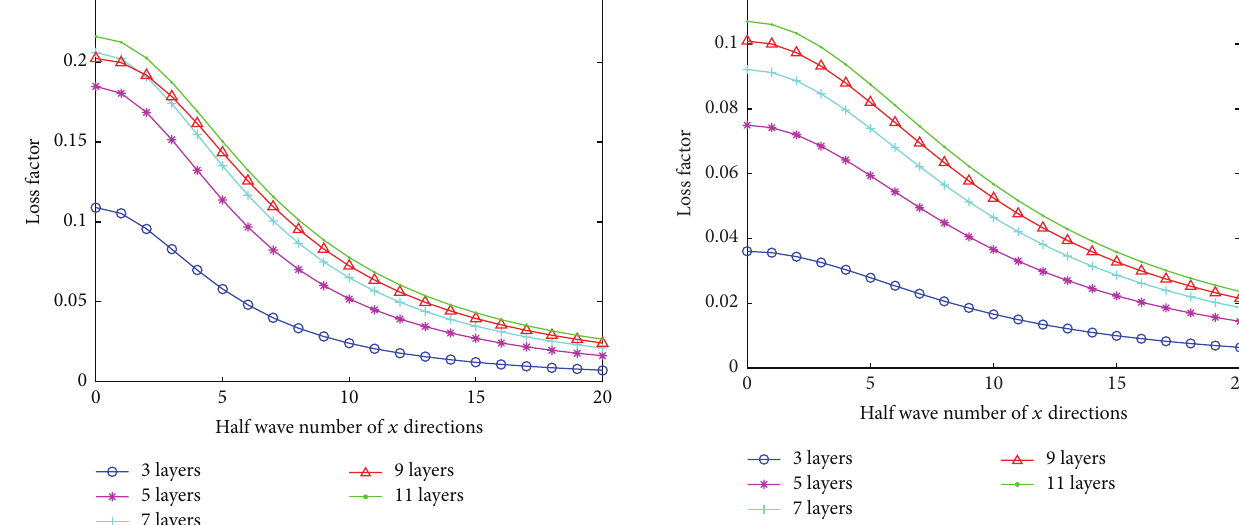
Figure 8: The loss factor of constrained damping plate with various layers ( 𝑛 = 5 ).